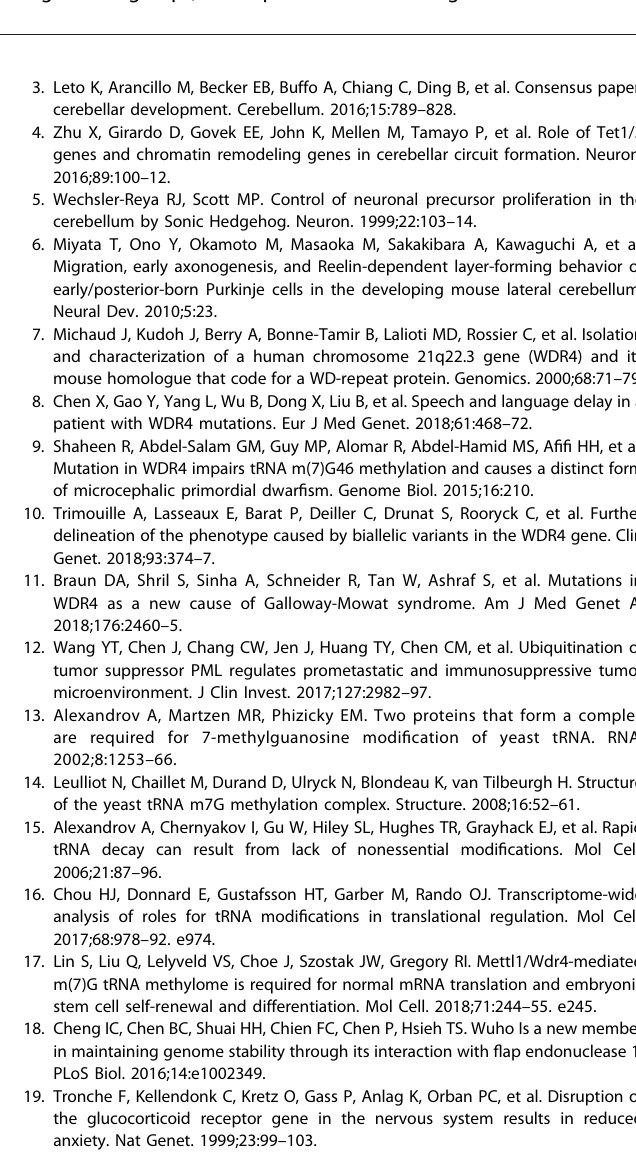
Fig. 7 Arhgap17 knockdown or Rac1 activation rescues the GNP proliferation defect caused by Wdr4 deletion. A , D , I Quantitative data measuring proliferation in GNPs isolated from P7 Wdr4 A-cKO mice and infected with lentiviruses carrying GFP and shRNA against Arhgap17 or control ( A ), treated with Rac1 activator ML099 or DMSO ( D ), or infected with lentiviruses carrying GFP and Wdr4 WTor mutants ( I ) at DIV 0. The capability of Arhgap17 shRNAs to knockdown the expression of Arhgap17 is shown in Fig. S7. The total cell numbers at DIV 0 and DIV 3 were counted. Data were from 3 ( A , I ) or 6 ( D ) cerebella in each group and analyzed using one-way ANOVA post hoc Holm- Š ídák ’ s test ( A ), two-tailed unpaired Student ’ s t -test with Welch ’ s correction (unequal variances, D ), or one-way ANOVA post hoc Dunnett ’ s test ( I ). p = 0.012 in sh Arhgap17 #1 v.s. shCtrl, and 0.0376 in sh Arhgap17 #2 v.s. shCtrl ( A ), p = 0.0082 in ( D ), p = 0.0001 in Wdr4 WT, >0.9999 in Wdr4 D166A, and 0.5937 in Wdr4 R172Q, compared to the control group ( I ). B , C , J , K Representative confocal images ( B , J ) and quantitative data ( C , K ) for measuring cell cycle exit in P7 Wdr4 A-cKO GNP cultures with Arhgap17 knockdown ( B , C ) or overexpression of WT or mutant Wdr4 ( J , K ). The GNPs were isolated, treated with EdU for 2 h, infected with lentiviruses carrying GFP and shRNA or cDNA at DIV 0, and harvested for staining analysis at DIV 3. Data were from 3 cerebella in each group and analyzed using one-way ANOVA post hoc Dunnett ’ s test. p = 0.0055 in sh Arhgap17 #1 v.s. shCtrl, and 0.0256 in sh Arhgap17 #2 v.s. shCtrl ( C ), p < 0.0001 in Wdr4 WT, >0.9999 in Wdr4 D166A, and 0.3568 in Wdr4 R172, compared to the control group ( K ). E , F Representative confocal images ( E ) and quantitative data ( F ) for measuring cell cycle exit in P7 Wdr4 A- cKO; Ai14 GNP cultures treated with ML099 or DMSO at DIV 0 and harvested 3 days later. The GNP cultures were treated with EdU for 2 h before ML099 treatment. Data were from 3 cerebella in each group and analyzed using two-tailed unpaired Student ’ s t -test without Welch ’ s correction (equal variances), p = 0.0052. G , H Representative confocal images ( G ) and quantitative data ( H ) from the EGL of lobule V – VI measuring the number of Ki67 + proliferating GNPs in the P7 Wdr4 A-cKO or control cerebella. The Wdr4 A-cKO and control mice were injected once with DMSO or ML099 (20 mg/kg) at P3, and harvested 4 days later. Data were from 5 cerebella in each group and analyzed using one- way ANOVA post hoc Turkey ’ s test, p < 0.0001 in ( H , A-cKO v.s. Ctrl with DMSO), and = 0.0439 in ( H , ML099 v.s. DMSO in A-cKO ). See also Fig. S8. Scale bars are 25 μ m in ( B , E , J ) and 50 μ m in (G). Data are represented as individual points and mean, or mean ± S.E.M.; * p < 0.05, *** p < 0.0005; n.s., non-signi fi cant. L Western blot analysis for Wdr4 expression in GNPs infected with lentiviruses carrying Wdr4 WT or mutants at DIV 0 and harvested at DIV 3, showing comparable expression levels among WT and mutants. M Western blot analysis for Arhgap17 expression in N2a cells overexpressing Wdr4 WT or mutants. The western blot results were quanti fi ed using ImageJ software. The protein levels were normalized fi rst to the Gapdh protein level in each group and then to the corresponding control groups, and expressed as fold changes at the bottom. All western blot analyses were done at least